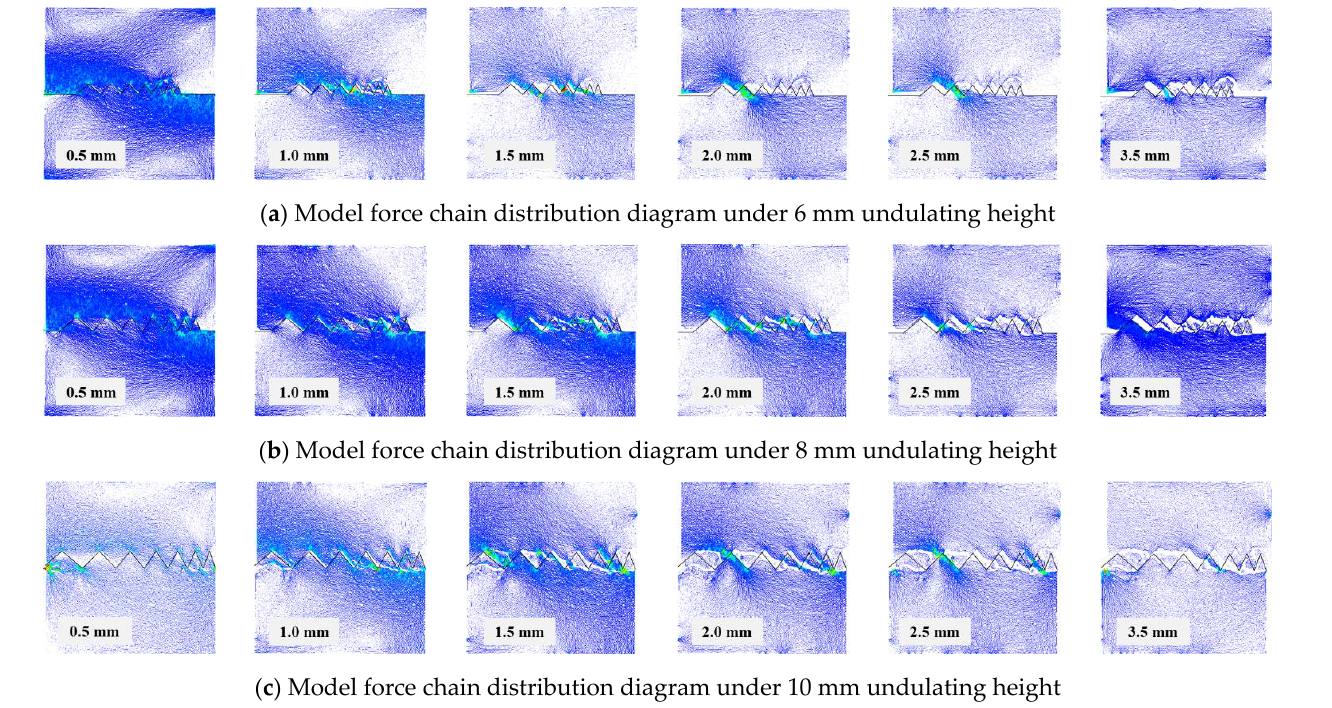
Figure 17. Model force chain distribution under different undulating heights.